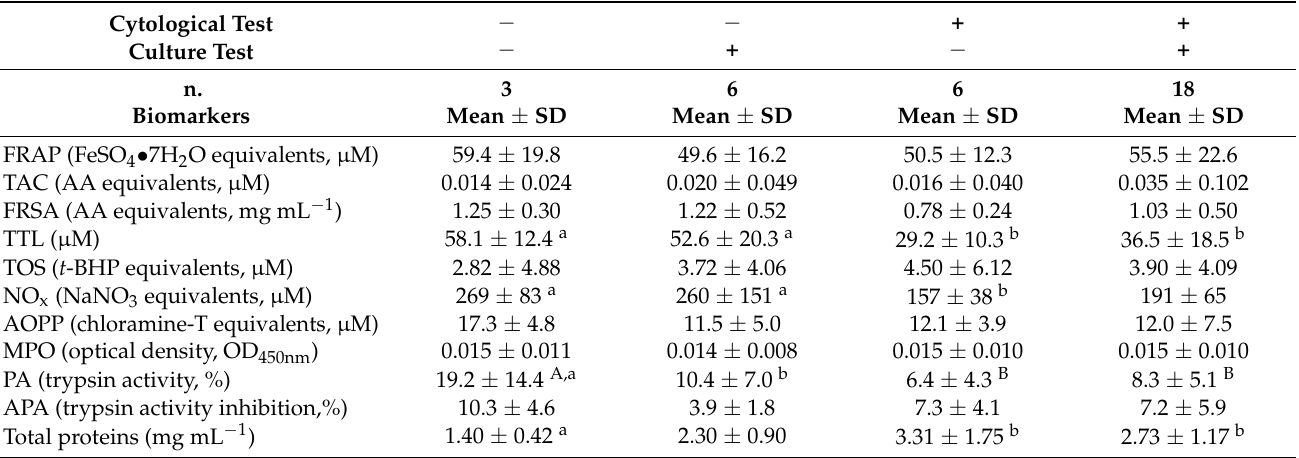
Table 4. Mean ( ± SD) values of oxidative, inflammation, and protease regulator biomarkers assessed in the uterine fluid of mares with negative and positive outcomes for the diagnosis of endometritis based on either microbiological or cytological assessments.